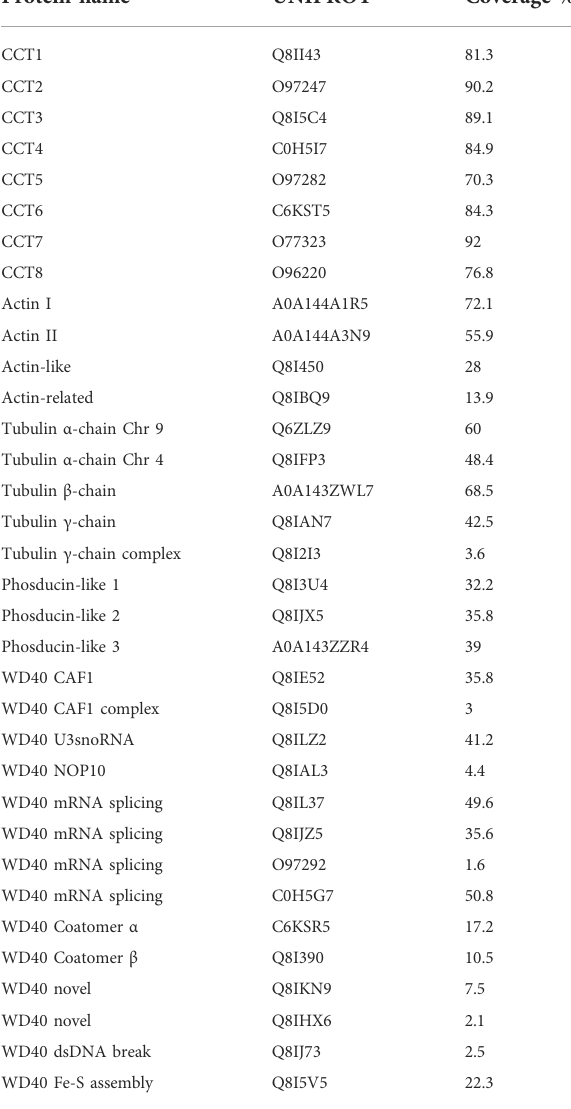
TABLE 1 Selected hits from the PfCCT